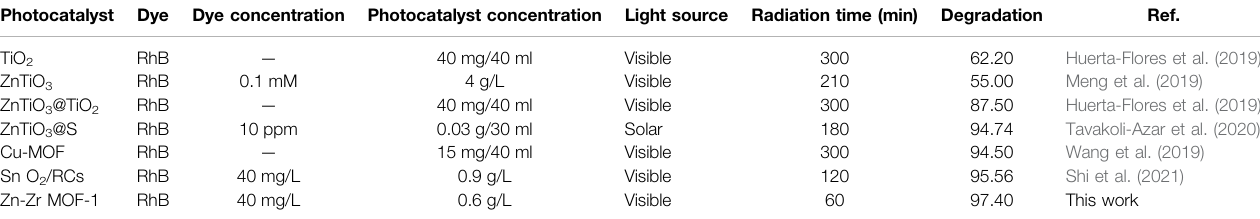
TABLE 3 | Degradation RB dyes by different photocatalysts as-synthesized. Photocatalyst Dye Dye concentration Photocatalyst concentration Light source Radiation time (min)